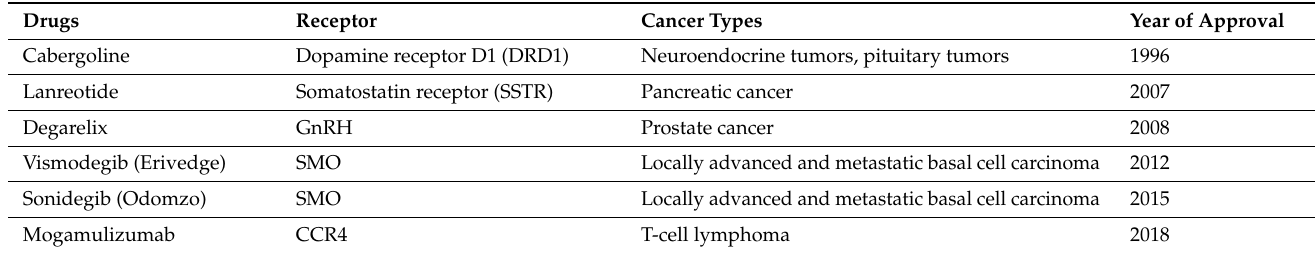
Table 3. Currently used FDA-approved drugs and antibodies against different cancers.